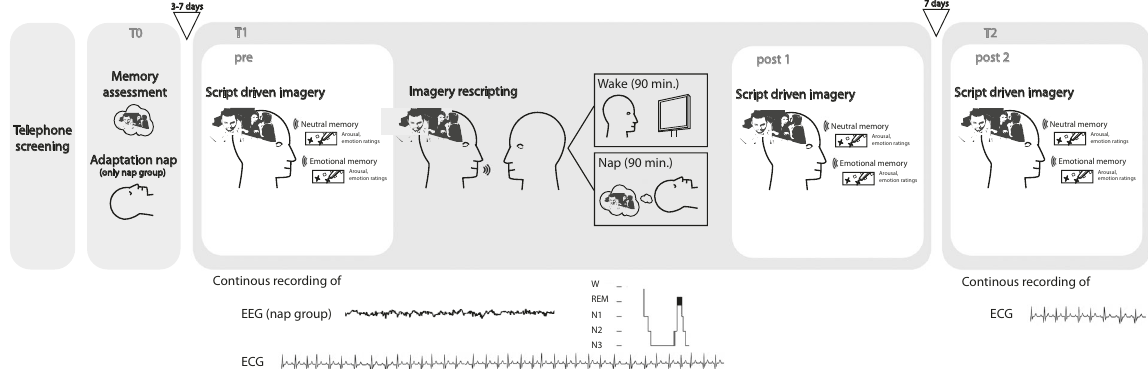
Fig. 1 Study design. The study design included a telephone screening interview and three subsequent appointments at the sleep laboratory (T0, T1, and T2). At T0 the target memory for the imagery rescripting and a neutral memory were evaluated and all information necessary for the script preparation was acquired. Participants of the nap group also took an adaptation nap at T0. The second session (T1) included the script-driven imagery procedure (pre) followed by the imagery rescripting intervention while HR was continuously measured. Afterward, participants either took a nap (nap group) or watched an emotionally neutral movie ( Kingdom of the Blue Whale , National Geographic; 2009) for a duration of 90 min (wake group). Another script-driven imagery assessment took place right after the nap/wake condition (post 1) and was repeated after seven days at T2 (post